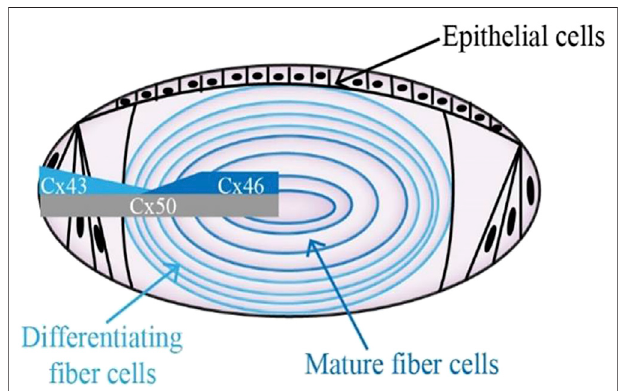
FIGURE 1 | Diagram showing the distribution ofconnexin hemichannels inthelens.ConnexinisoformCx43ismainlyexpressedintheanteriorepithelial layer. Cx46 can be found in the differentiating lens fi broblasts and mature lens fi broblasts. The expression of Cx50 stays the course of entire lens